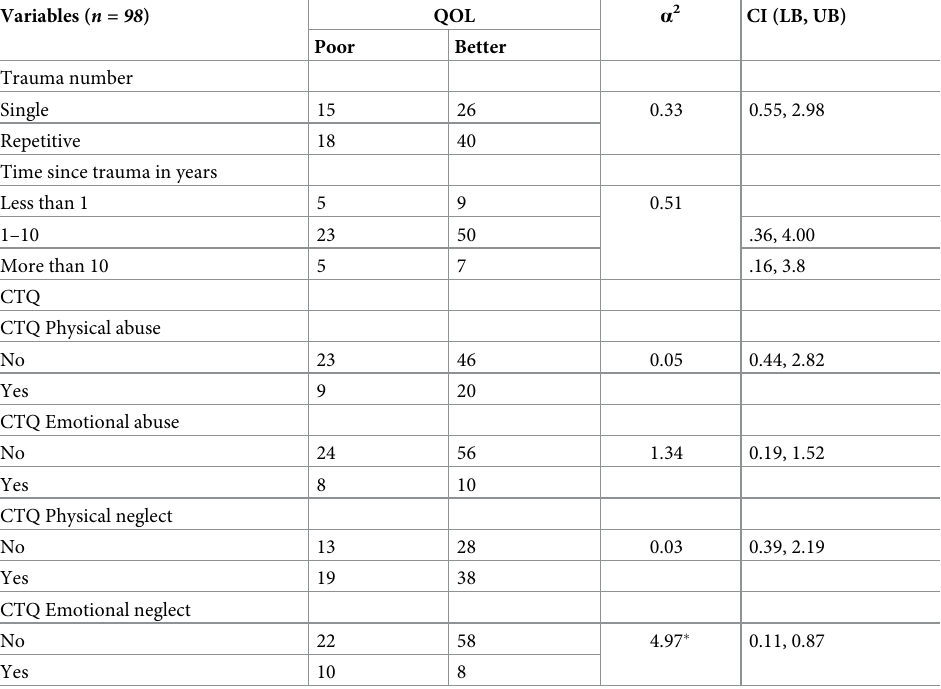
Table 2. Child trauma, trauma variables and quality of